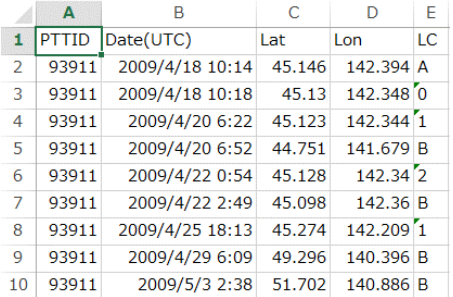
Figure 2 (a). Sample data acquired from ARGOS